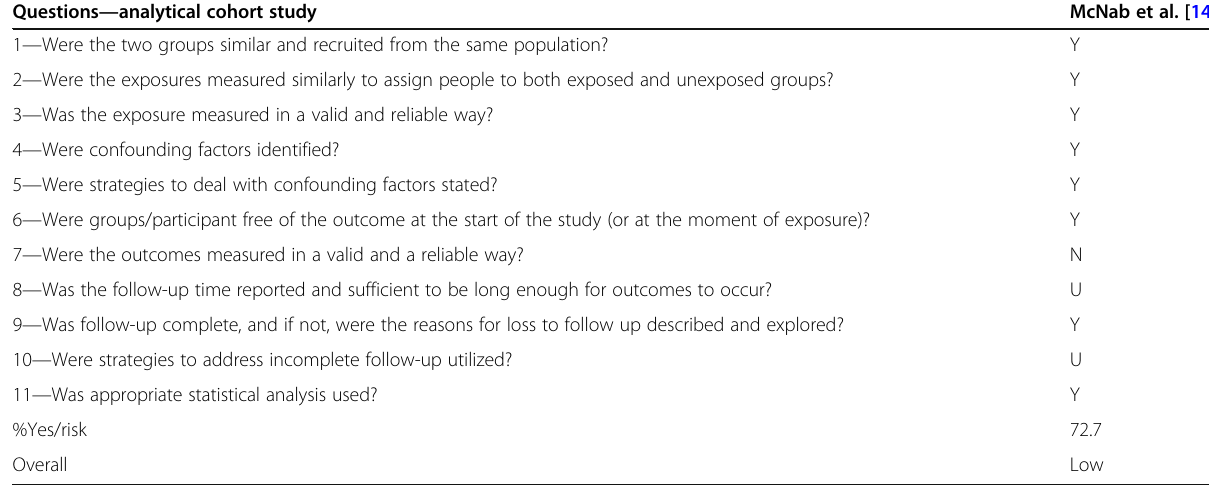
Table 4 RoB of cohort study in the qualitative synthesis based on the Joanna Briggs Institute Critical Appraisal Checklist Questions — analytical cohort